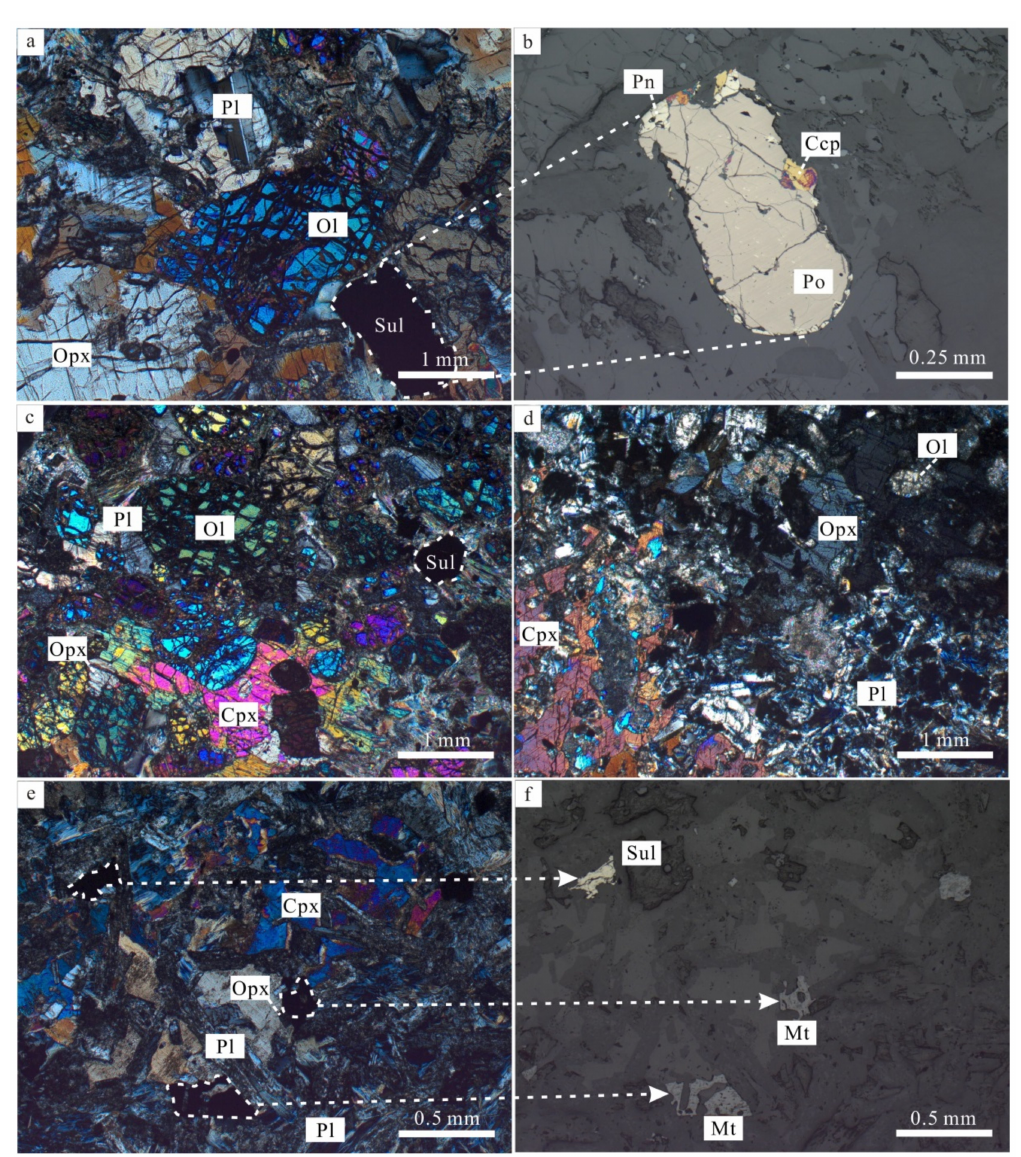
Figure 3. Microphotographs of rocks in the Baixintan intrusion. ( a – c ) Sulfide-bearing lherzolite; ( d ) olivine gabbro; ( e , f ) gabbro. Ol = olivine, Opx = orthopyroxene; Cpx = clinopyroxene; Pl = plagioclase, Sul = sulfide, Po = pyrrhotite, Pn = pentlandite, Ccp = chalcopyrite, Mt =